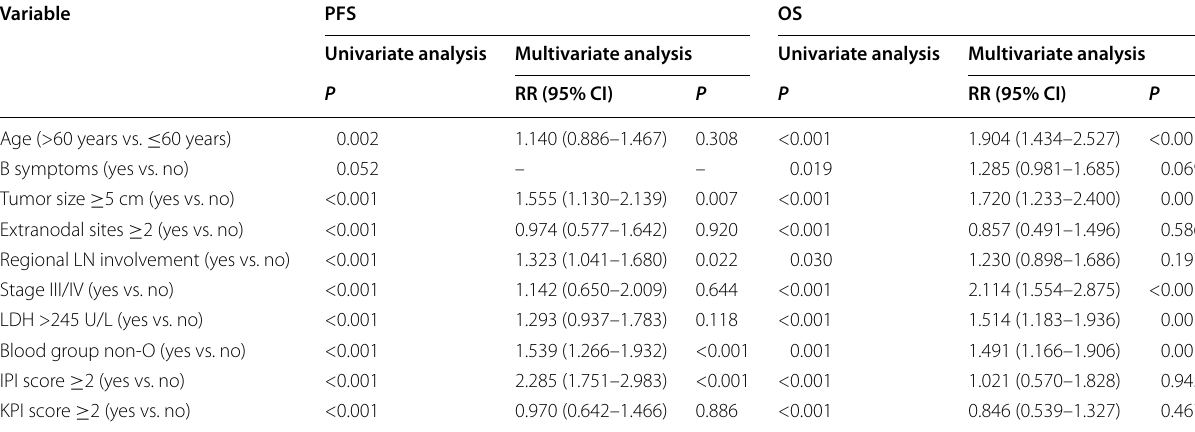
Table 4 Univariate and multivariate analysis of prognostic factors for PFS and OS in patients with